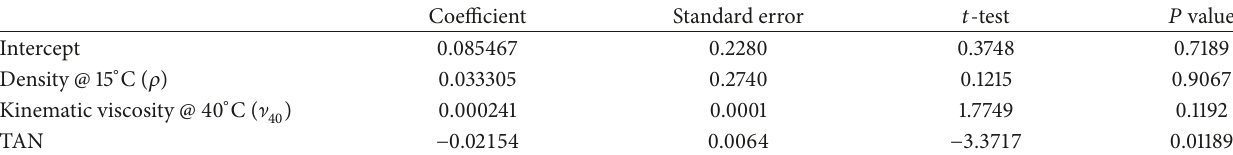
Table 10: Inference in linear